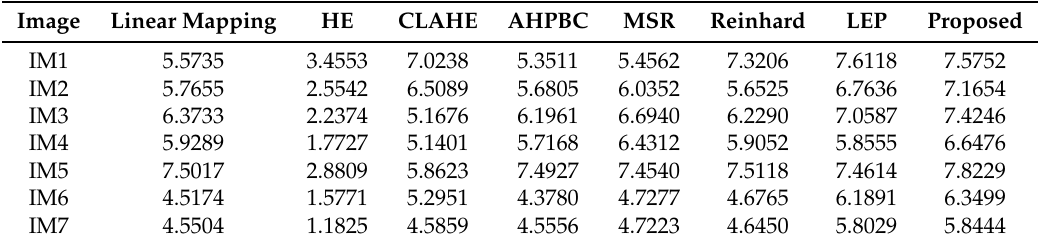
Table 3. The entropy of the